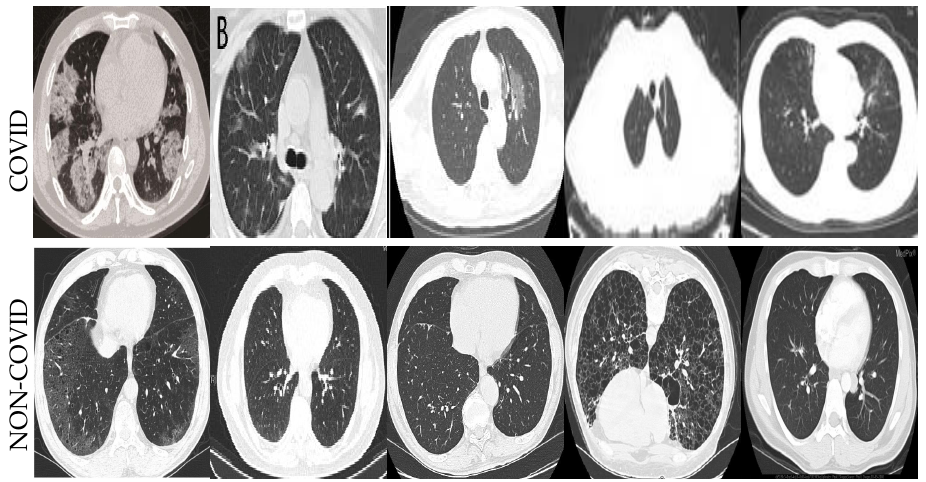
Figure 1. Representative images of the COVIDCT [1] dataset employed for training and evaluation of